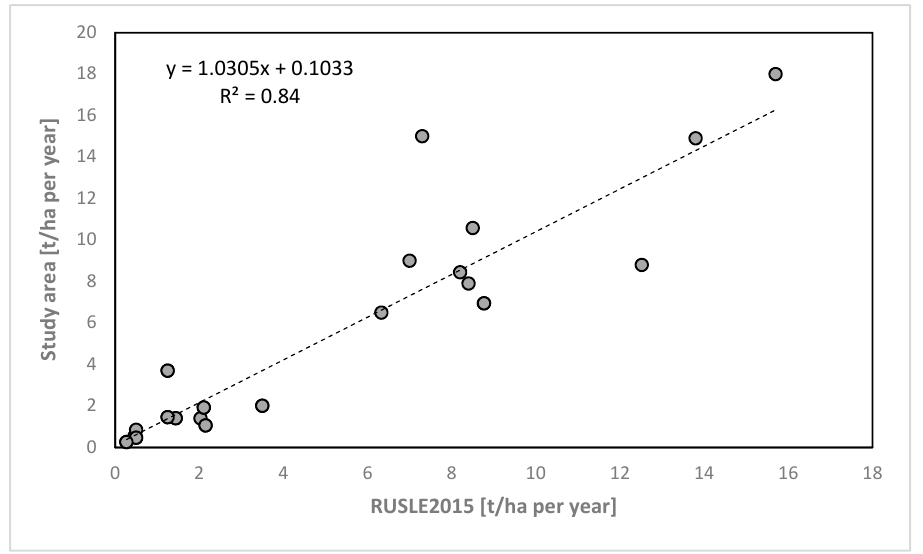
Figure 6. Comparison of the average soil loss estimated by the continental scale model (RUSLE2015) against local/regional estimates obtained from literature.